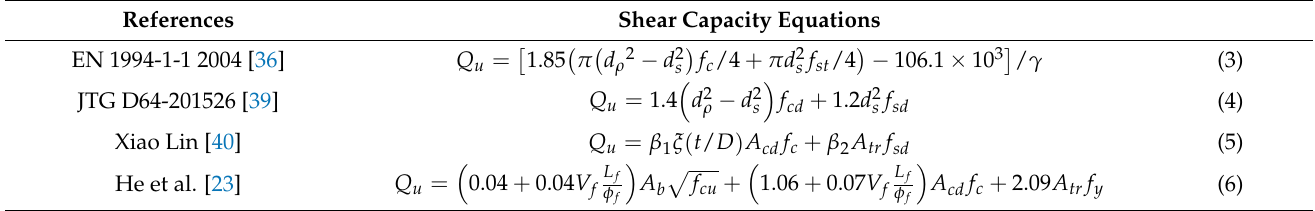
Table 4. Typical prediction formulas for the shear capacity of PBL connector.